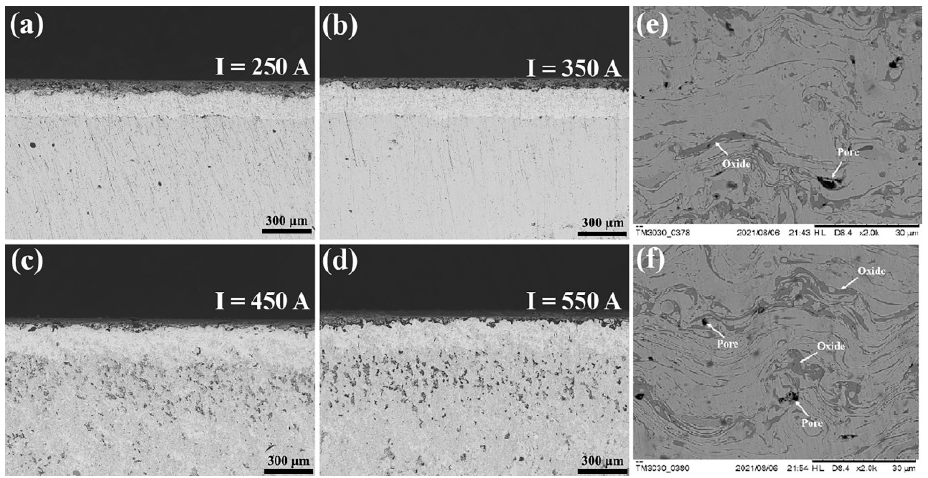
Figure 5. ( a – d ) Cross-section morphology of FeCoNiCrMo 0.2 high entropy alloy coating on BS960 high strength steel, micro-structure of FeCoNiCrMo 0.2 high entropy alloy coating on BS960 high strength steel ( e ) 350 A, ( f ) 550 A.